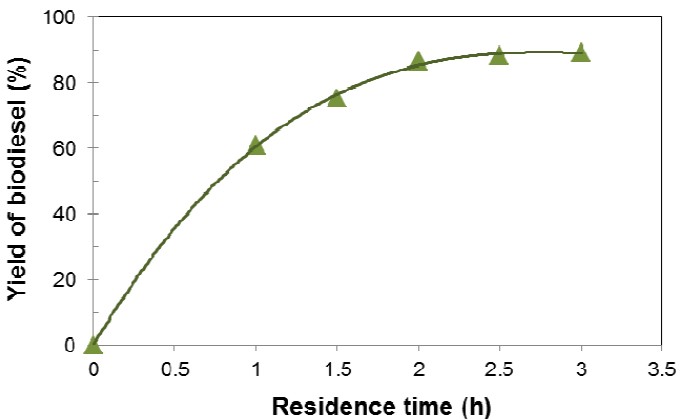
Figure 4. Effect of residence time on the yield of biodiesel in